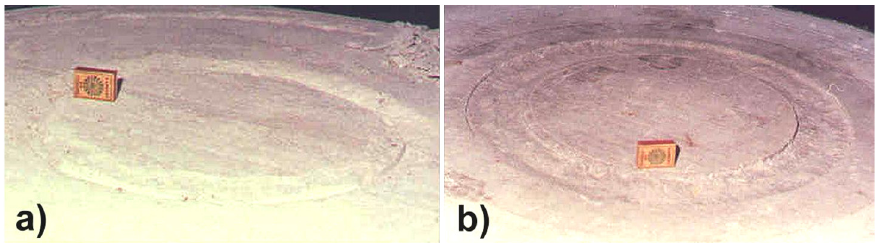
Figure 16. View of the sample surface after mining with a symmetrical disk tool—disk edge angle 2 β = 110°, mining radius R u = 350 mm: ( a ) without high pressure water jet assistance, ( b ) with high pressure water jet assistance—slots depth g = 10 mm, slots spacing 2B = 70 mm [1].